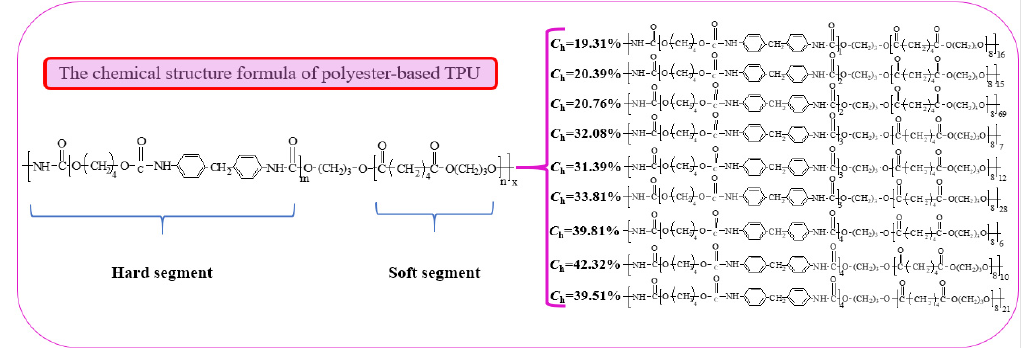
Figure 7. Chemical equation of polyester-based TPUs.